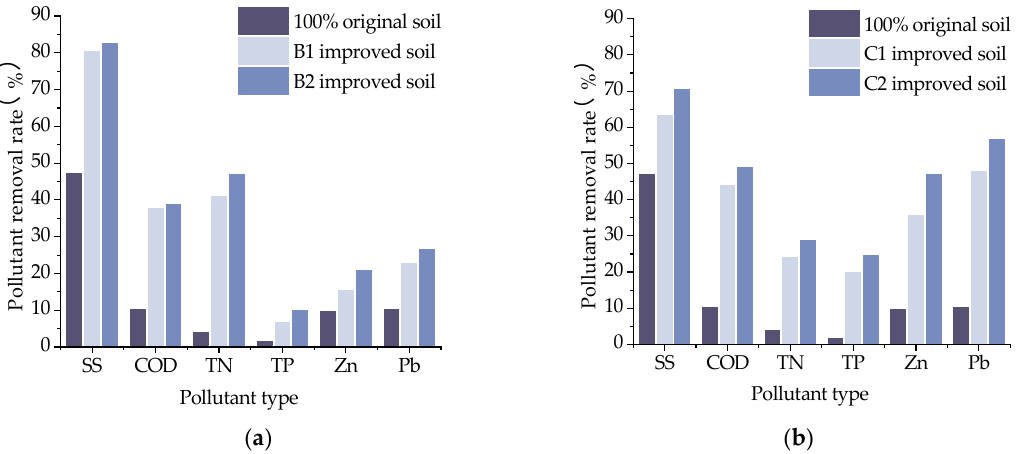
Figure 13. Pollution removal rate of soil amended with ameliorants: ( a ) Sand-amended soil; ( b ) Grain shells-amended soil.